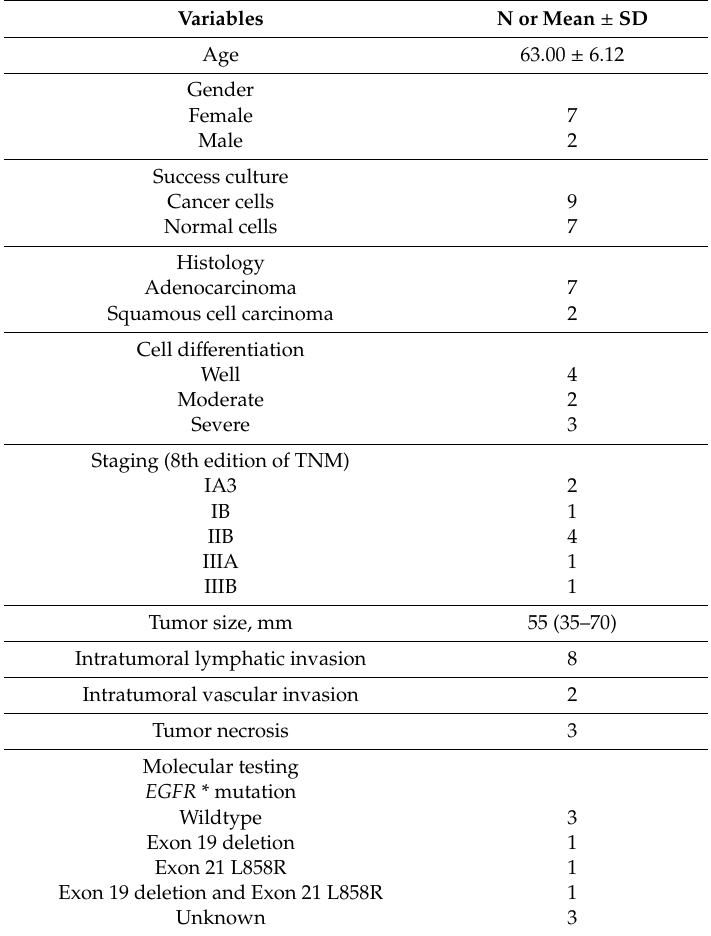
Table 7. Patient characteristics (nine